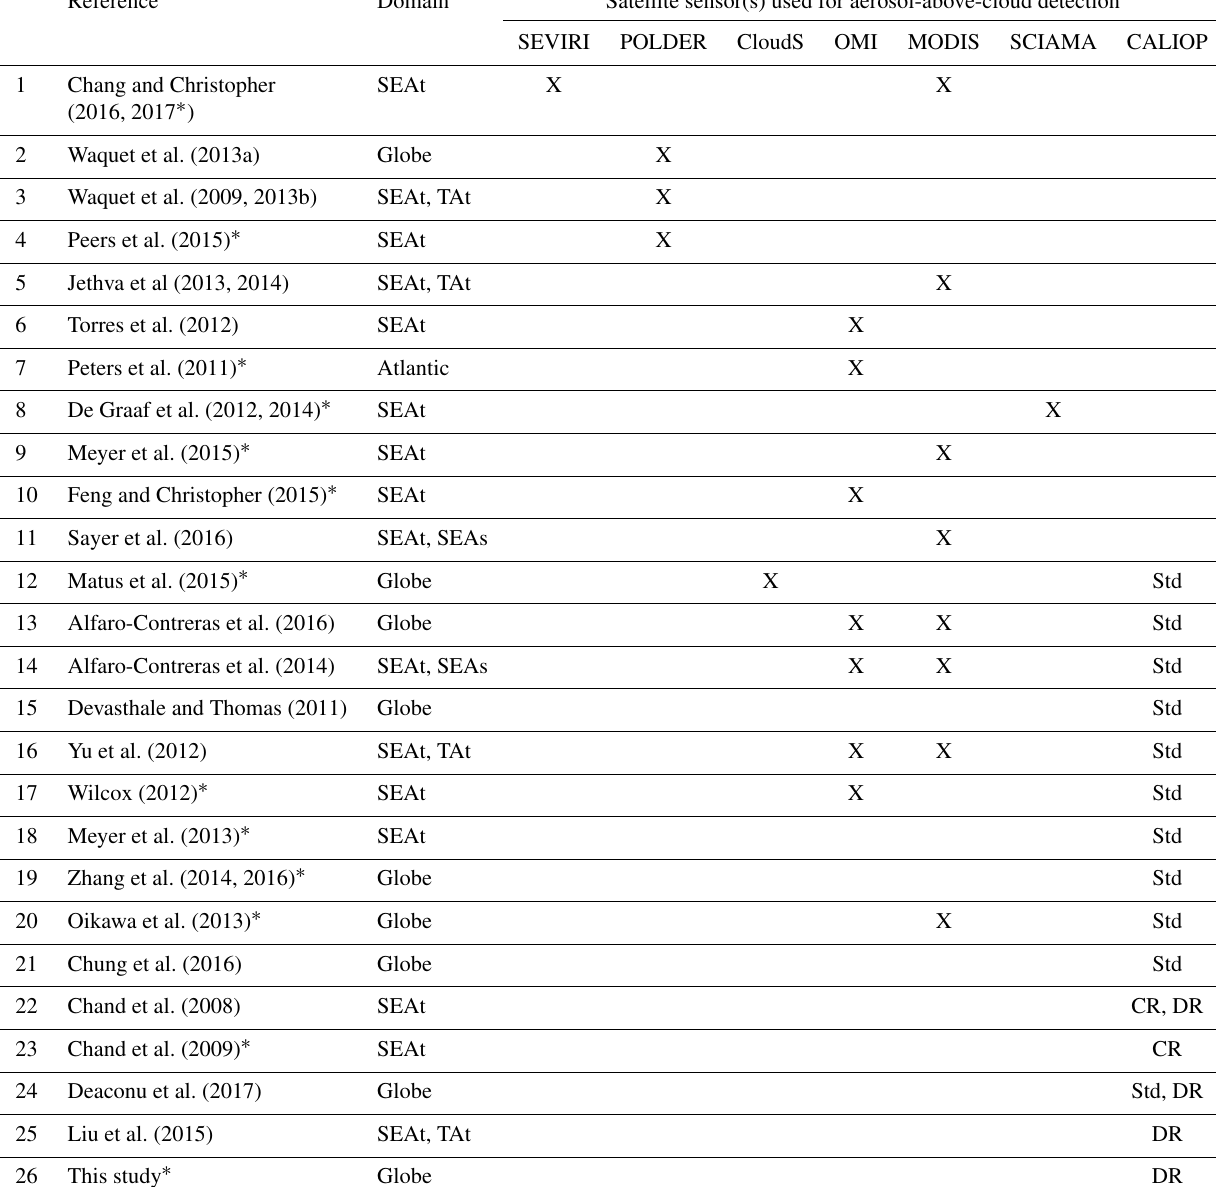
Table 2. Studies that observe AAC using passive and active satellite sensors (i.e., from left to right, SEVIRI, POLDER, CloudSat, OMI, MODIS, SCIAMACHY, CALIOP; see Appendix C for acronyms). When using CALIOP, the authors either use the standard Level 2 products (Std), the Depolarization method (DR) (Hu et al., 2007b) or the color ratio method (CR) (Chand et al., 2008). SEAt stands for southeast Atlantic, SEAs for SE Asia, NEAs for NE Asia and TAt for tropical